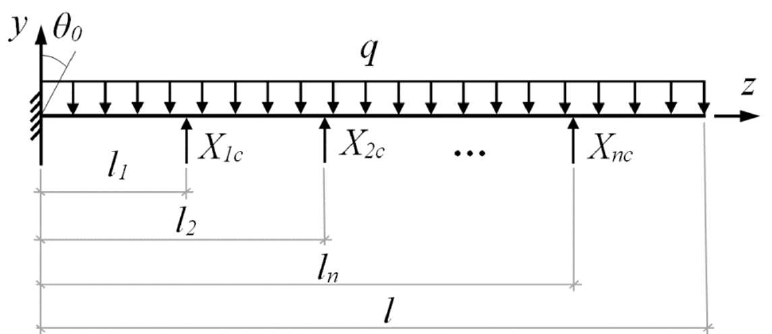
Figure 9. Calculation scheme of the pipeline when fixing its position in the sections in which the grips of the proposed devices are installed: θ 0 —angle between the axis of the pipeline and the positive direction of the OZ axis at the point of contact between the pipeline and the wall of the trench (fixed support angle), counted clockwise, rad; q —distributed load from the own weight of the pipeline, N/m.